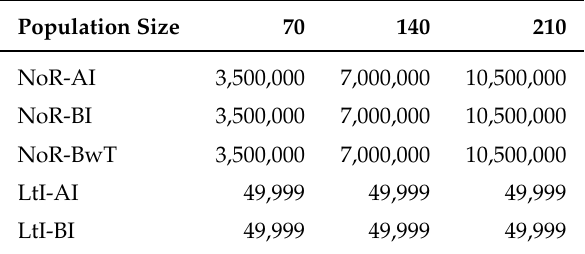
Table 2. Maximum values of the analyzed